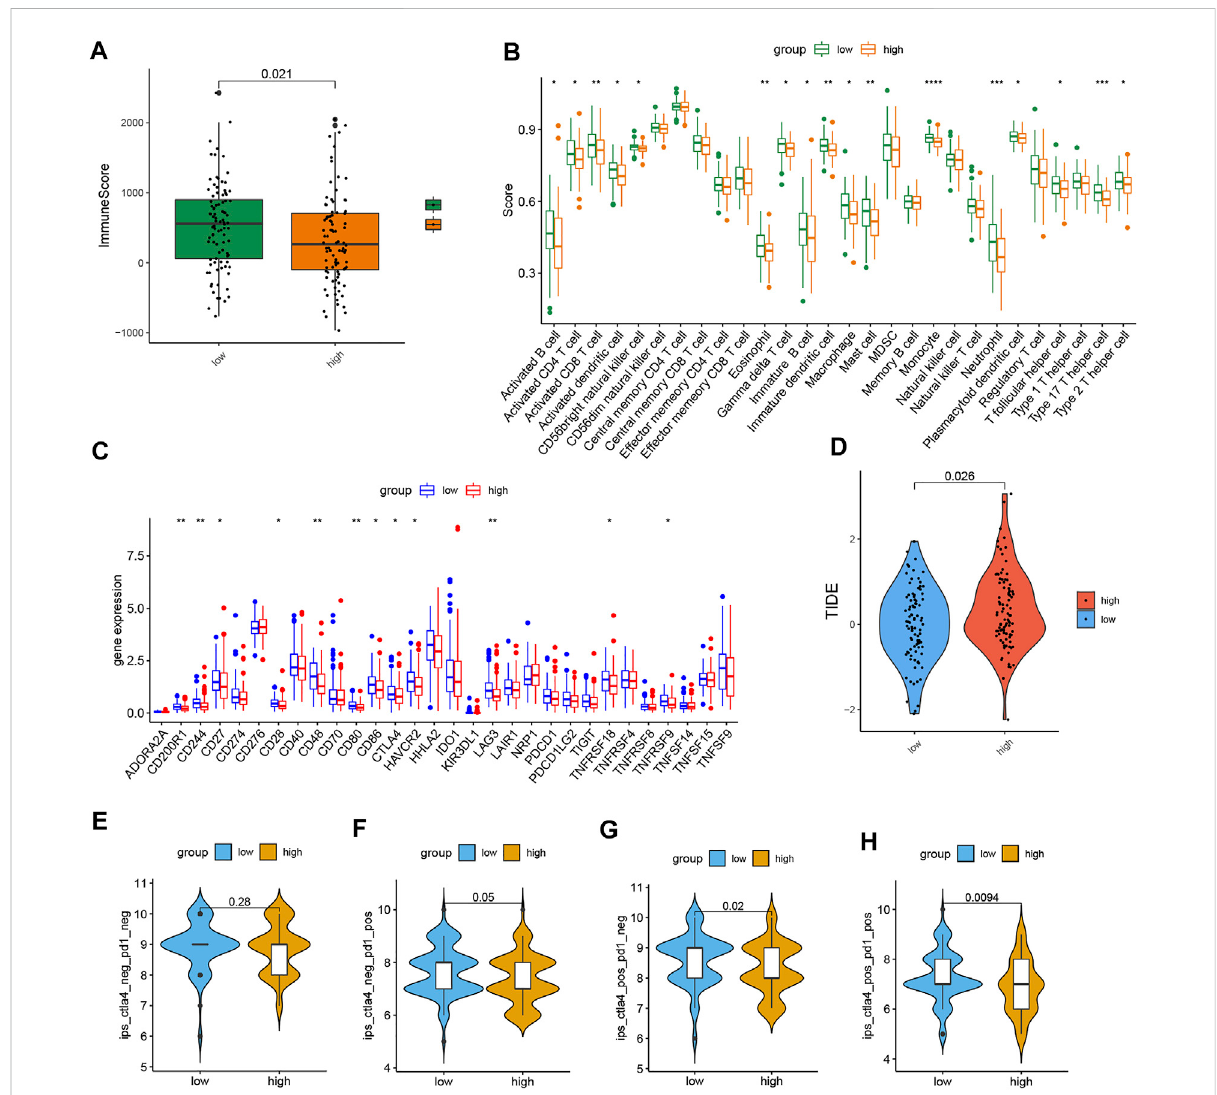
FIGURE 5 Comparison of immune-related analyses and immunotherapy response in the two subgroups. (A) Boxplot of the ESTIMATE score in the two subgroups. (B) Boxplot of the activity of immune in fi ltration cells in the two groups. (C) Boxplot of the expression level of immune checkpoint in the two subgroups. (D) TIDE score. (E – H) Immunophenoscore difference of COAD with different status of CTLA or PD-1. ( p < 0.05 *, p < 0.01 **, p < 0.001 ***, and p < 0.0001